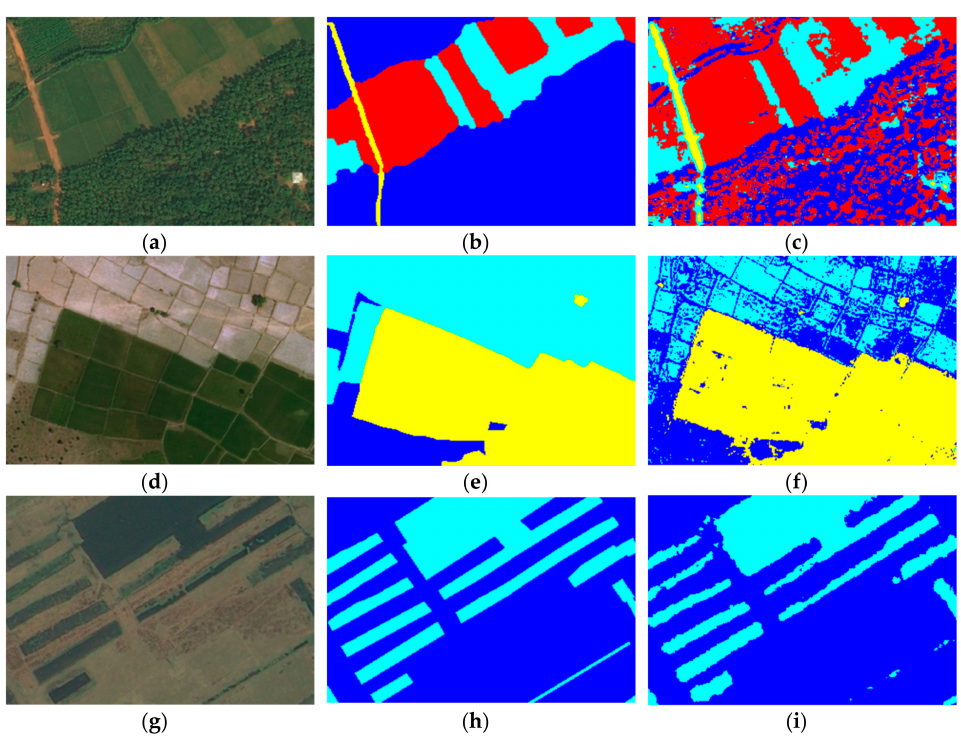
Figure 1. Segmentation results for satellite images from our dataset part 1 [23] (di ff erent clusters for each image are marked with selected colours): ( a ) satellite image “71619_sat,” ( b ) corrected GT image “71619_gt” with 4 clusters, ( c ) k-means ++ segmentation results “71619_seg” of “71619_sat,” ( d ) satellite image “161109_sat,” ( e ) corrected GT image “161109_gt” with three clusters, ( f ) k-means ++ segmentation results “161109_seg” of “161109_sat,” ( g ) satellite image “676758_sat,” ( h ) corrected GT image “676758_gt” with two clusters, ( i ) k-means ++ segmentation results “676758_seg” of